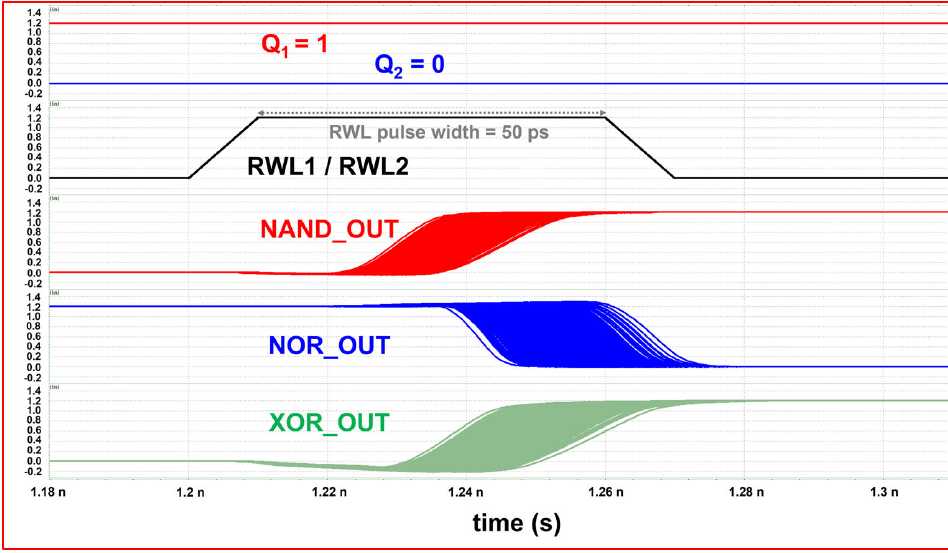
Figure 2. Global Monte Carlo simulation when Q 1 , Q 2 is “10” or “01,” [11].